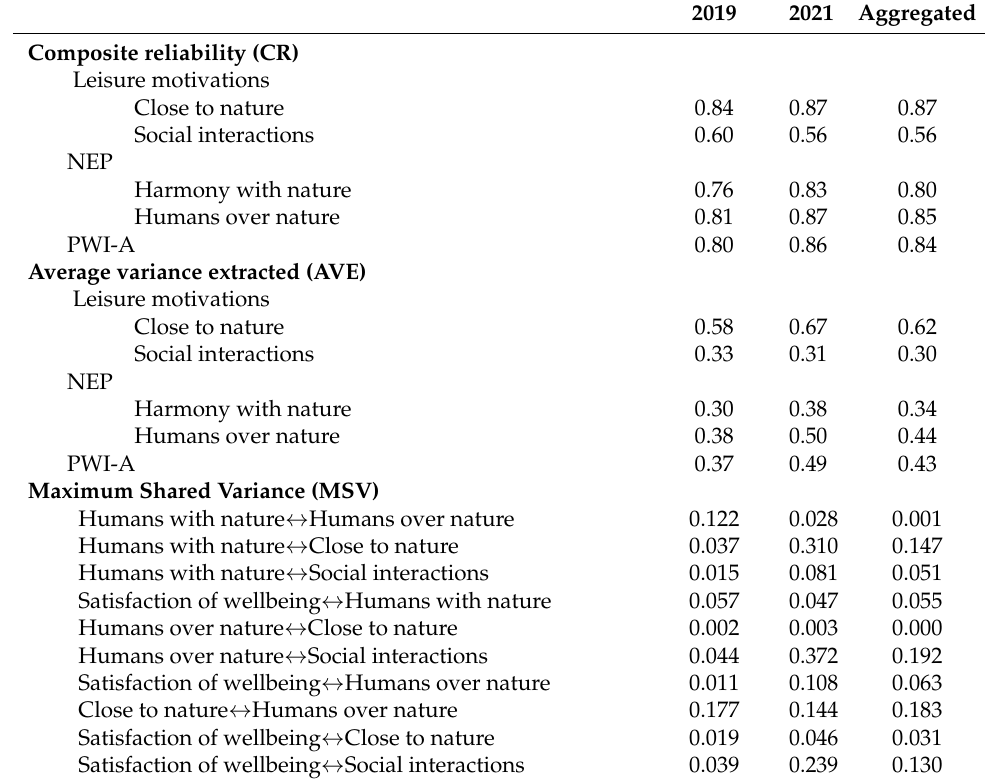
Table 7. Composite reliability, average variance extracted, and maximum shared